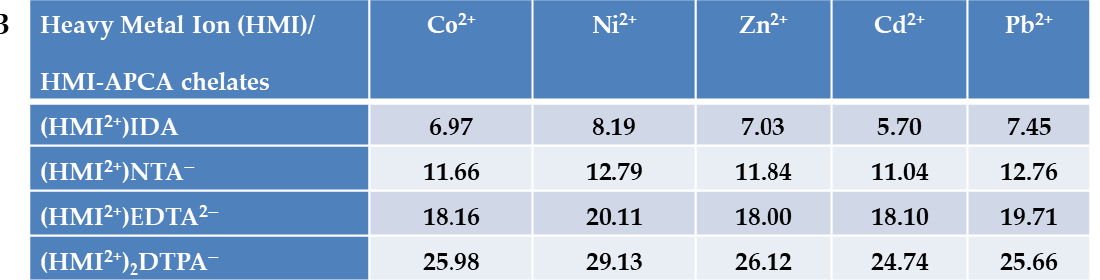
Figure 1. ( A ) Chemical structures of the most important aminopolycarboxylic acids (APCAs) used in heavy metal ions (HMIs) removal/recovery processes; ( B ) pK values for some HMIs-APCAs chelates, Adapted with permission from reference [6], 2013, Elsevier Ltd.